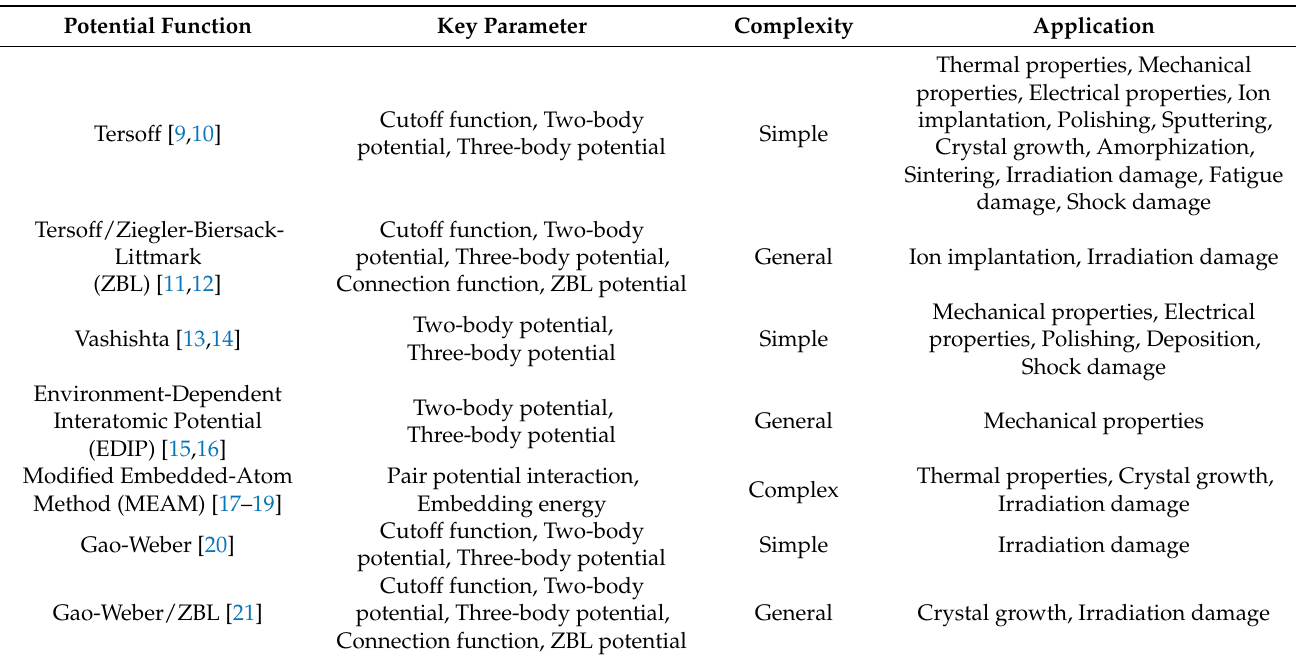
Table 1. The common potential functions for MD simulations of silicon carbide